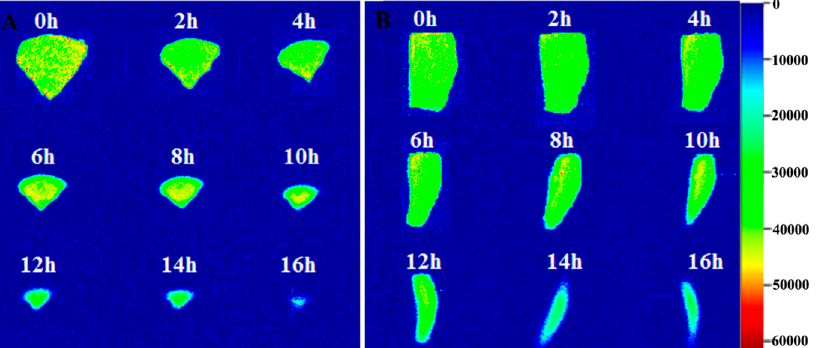
Figure 4. Vertical-sectional ( A ) and cross-sectional ( B ) MRI images of G. elata during the drying process at 60 °C.